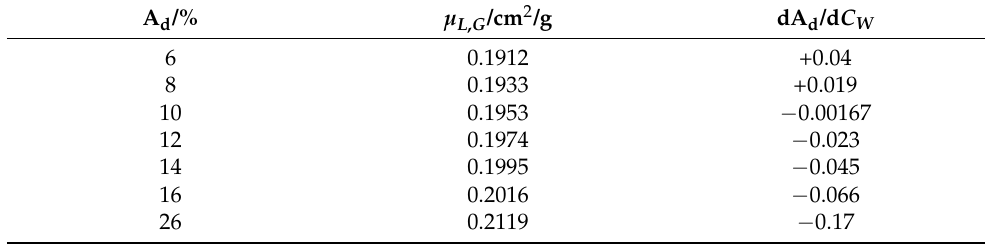
Table 3. Relationship between the measured ash content and the moisture content of